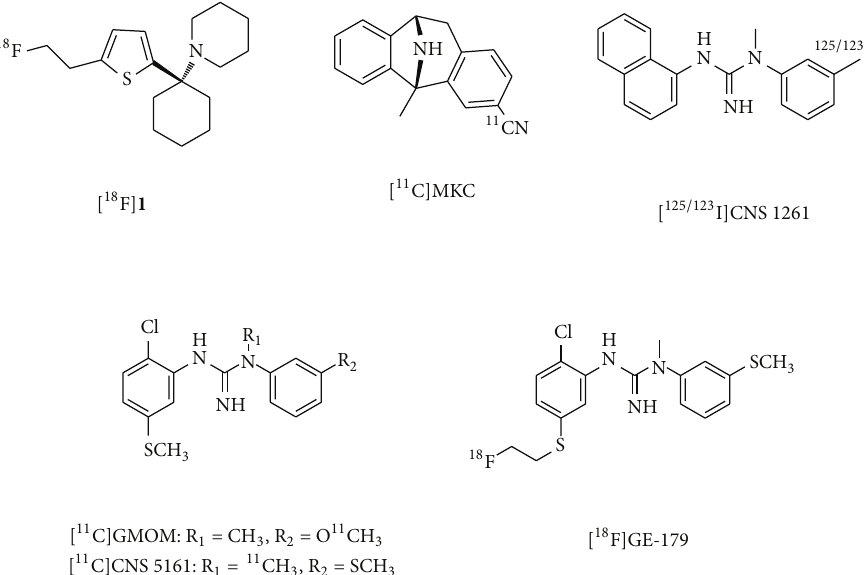
Figure 1: Chemical structure of imaging probes for channel blocker binding site of NMDARs.